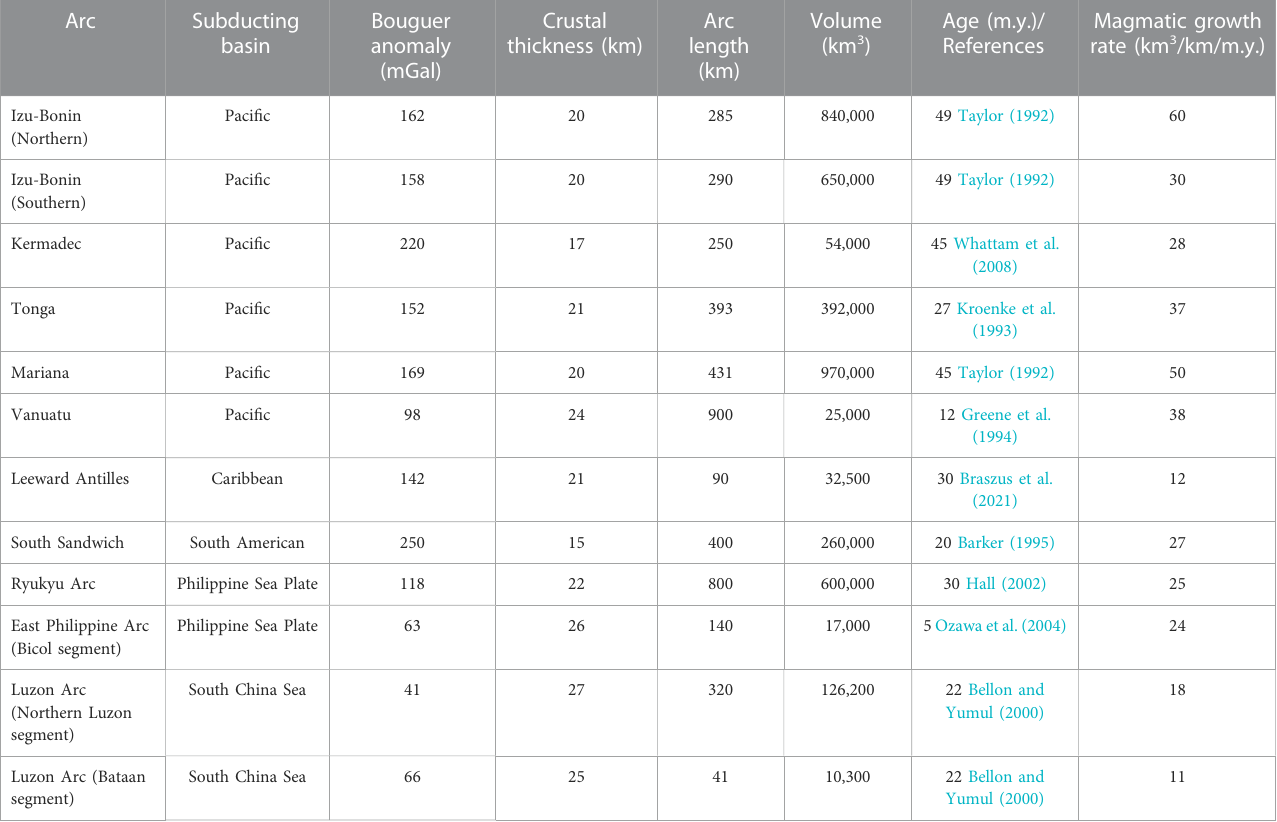
TABLE 1 New magmatic growth rates computed for oceanic island arcs using Bouguer anomaly-derived crustal thicknesses. Crustal thicknesses were computed following the methodology forwarded by Reymer and Schubert (1984). Volume Crustal Arc Arc Subducting Bouguer Age (m.y.)/ Magmatic growth (km 3 ) thickness (km) length basin anomaly References rate (km 3 (km) (mGal)